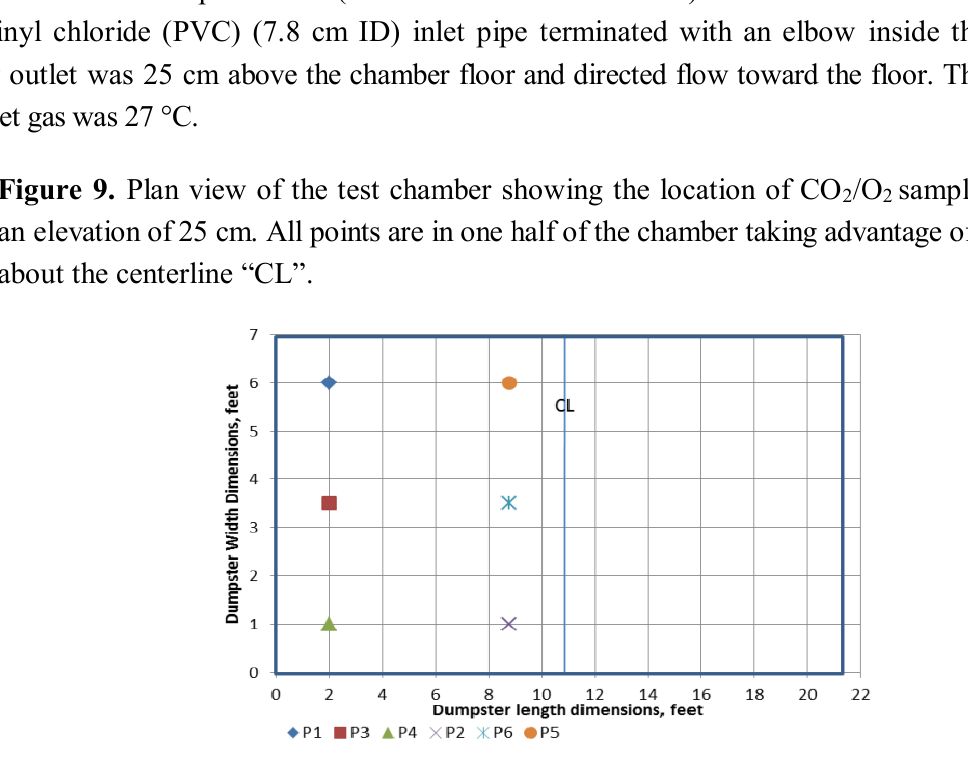
/O sample points at 2 2